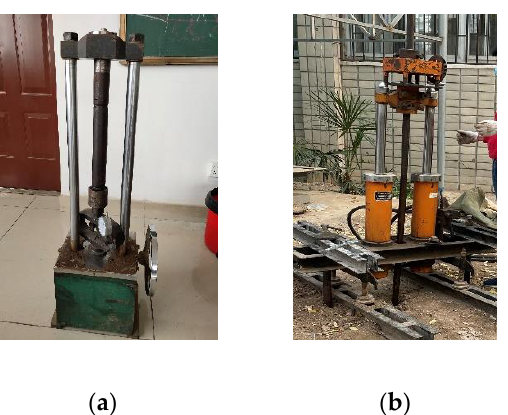
Figure 9. Probe calibration and field exploration: ( a ) probe calibration frame; ( b ) probe pushing-down device.